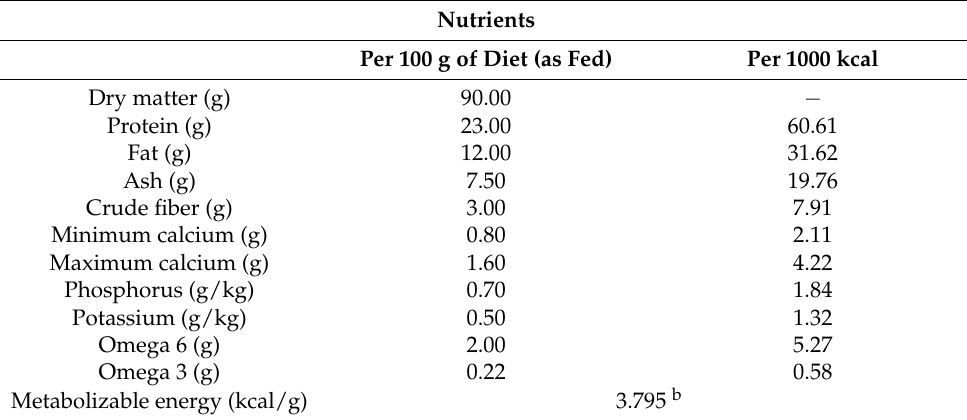
Table 2. Diet composition a as fed and per 1000 kcal and ingredients * according to the manufacturer of the control diet used in the